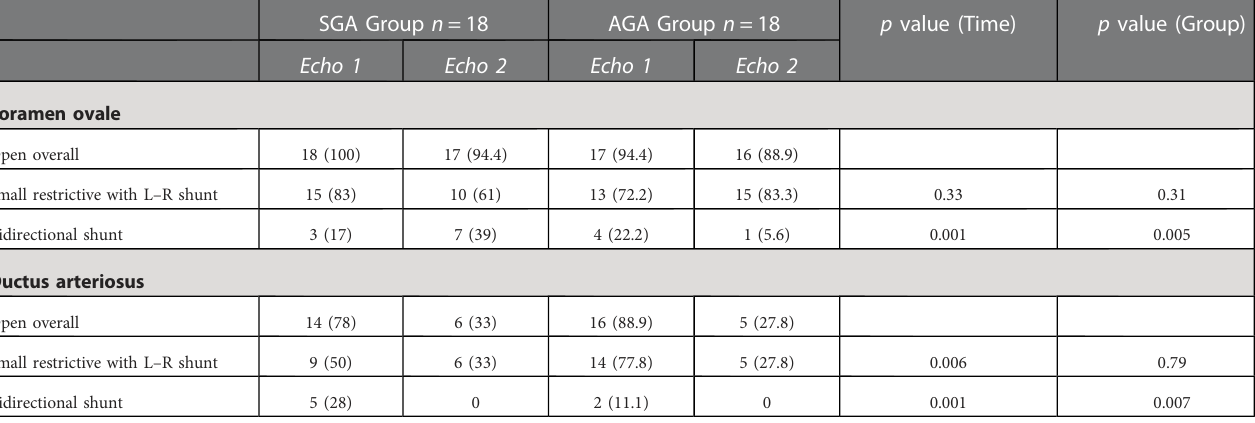
TABLE 6 Effect of group and time on transitional